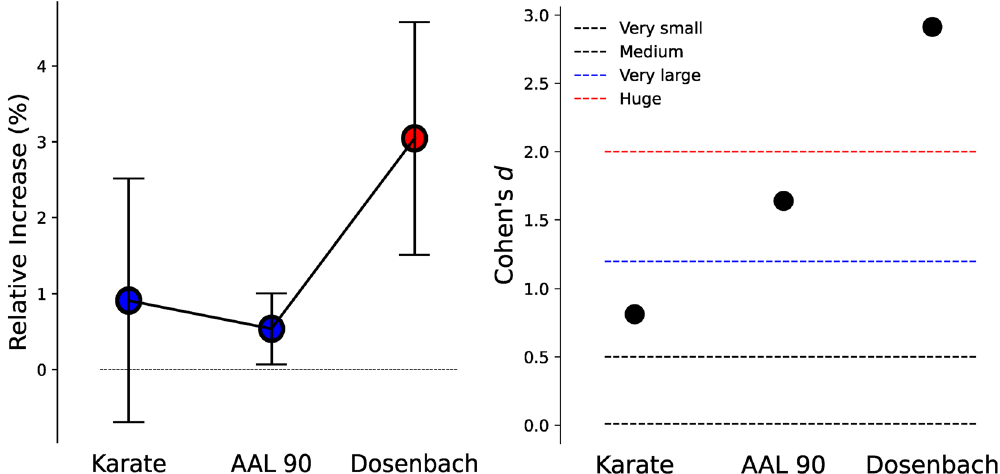
Figure 6. Left: Percentage of relative increase of the QA result with respect to LCDA [MEAN±SEM]. Significancy (p<0.05, one-sided Welch’s t-test) is indicated in red. See exact values in Table S2. Errors bars were computed by propagating the SEM of the results with LCDA and QA. Dashed black line indicates the no increase threshold. Right: Effect size measured by Cohen’s d . Horizontal dashed and colored lines separate effect sizes according to standard thresholds. Cohen’s d is a measure of the effect size present in the two populations without assessing the statistical